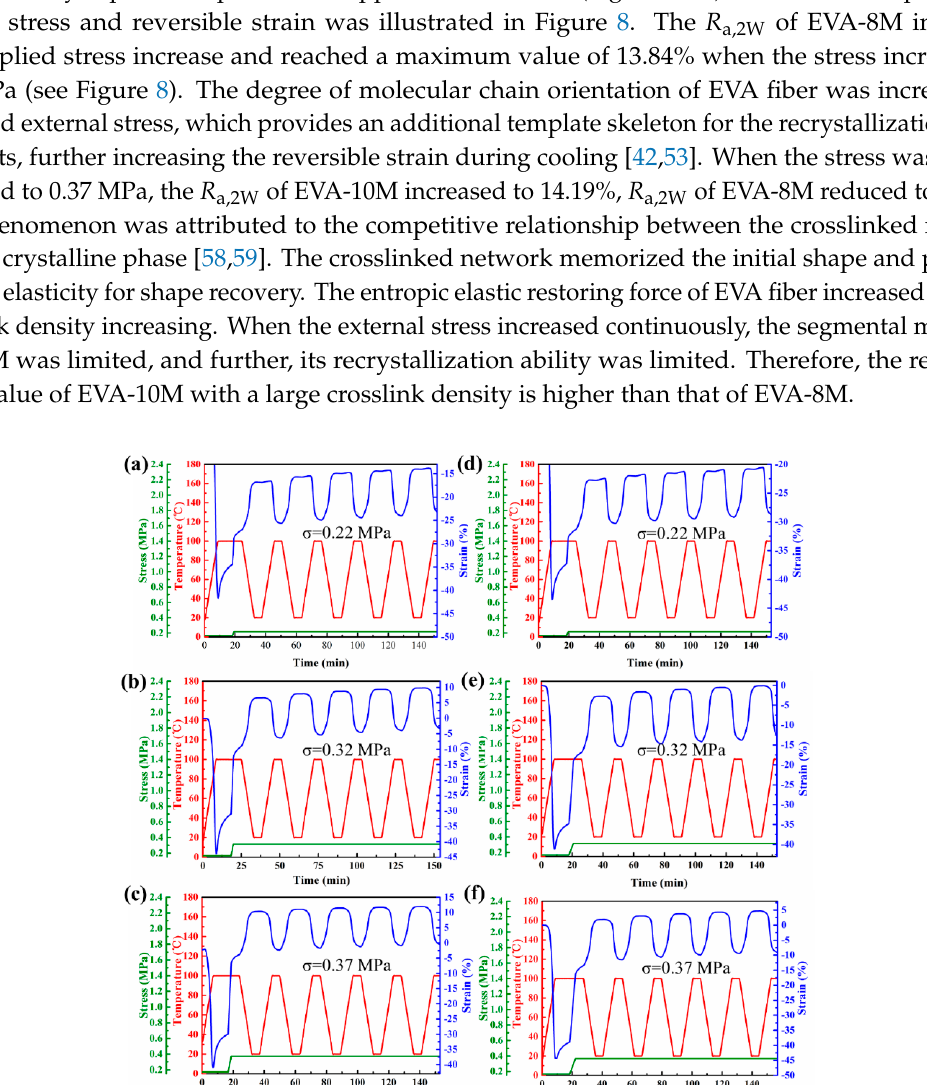
Table 3. 2W-SME of different EVA fiber under 0.27 MPa.